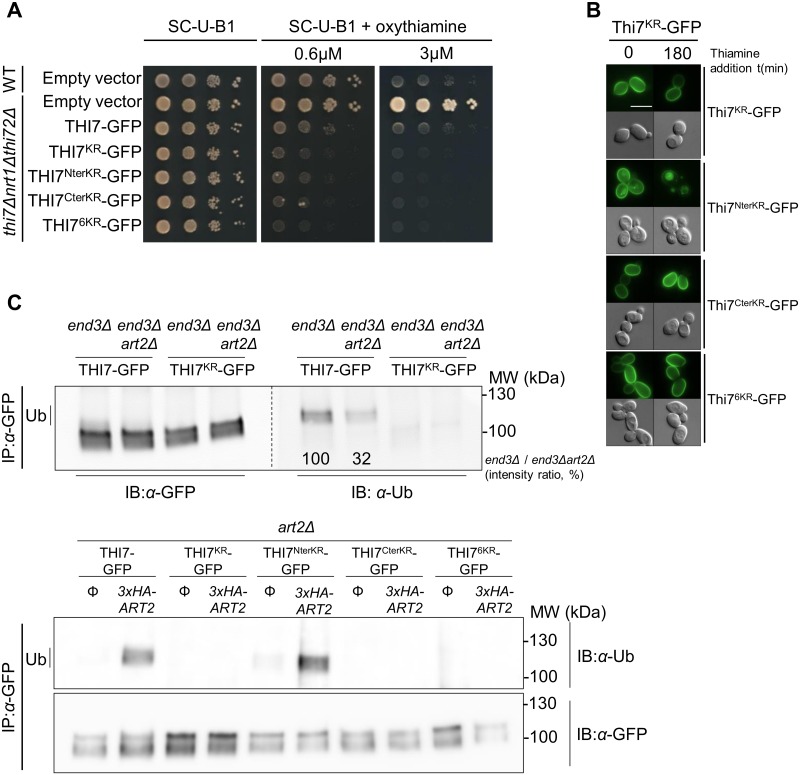
The Art2-dependent ubiquitylation of Thi7-GFP C terminus is required for its endocytosis.(A) GFP-tagged KR-mutated THI7 was expressed in a thi7Δnrt1Δthi72Δ strain and grown in a thiamine-free medium. Serial 10-fold dilutions of yeast cells in early log phase were spotted on thiamine-free oxythiamine-containing medium. The expression of pRS416 (empty vector) and the nontagged version were used as controls. Oxythiamine was transported by all the KR Thi7 mutants (B) Localization of the different KR mutant versions of Thi7-GFP in the WT strain after thiamine treatment (final concentration: 100 μM): Thi7KR-GFP, Thi7NterKR-GFP, Thi7CterKR-GFP, and Thi7Cter6KR-GFP. (C) Top: THI7-GFP and THI7KR-GFP were expressed in end3Δ and end3Δart2Δ strains and grown in thiamine-free medium to early log phase before a 30-min incubation with 100 μM thiamine. Bottom: THI7-GFP, Thi7KR-GFP, Thi7NterKR-GFP, Thi7CterKR-GFP, or Thi7Cter6KR-GFP were expressed in art2Δ strain (complemented or not with 3xHA-ART2) and grown in thiamine-free medium to early log phase before a 30-min incubation with 100 μM thiamine. After solubilization, IP of transporters was performed using the GFP-Trap kit. Samples were immunoblotted with anti-GFP and anti-Ub. Quantification is based on the intensity of the Ub band and normalized to the intensity of the corresponding GFP signal. GFP, green fluorescent protein; IB, immunoblotting; IP, immunoprecipitation; KR, lysine-to-arginine; Ub, ubiquitin; WT, wild type.